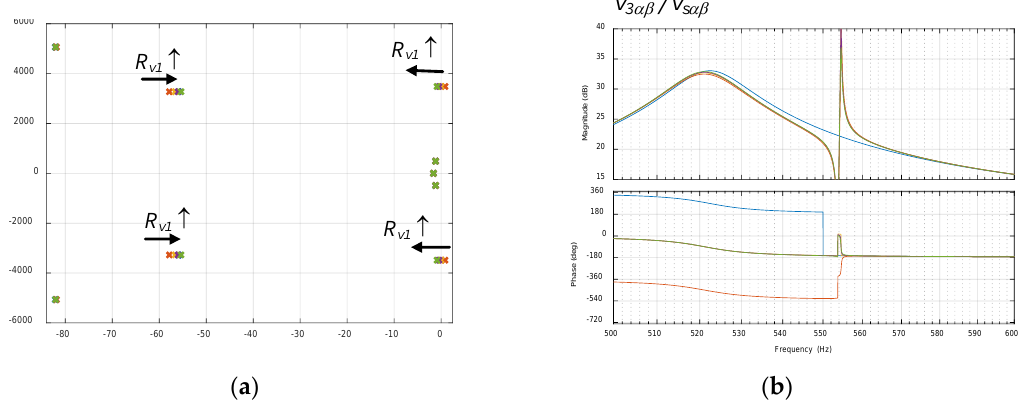
Figure 14. Dominant poles and Bode plots of the voltage at the Pcc with altered AC grid impedance ( C 1 ·1.4) and with different active resistances ( R v 1 = 1.51 k Ω multiplied by factors (1 1.5 2 3)) programmed at 550 Hz. ( a ) Dominant poles of the system, ( b ) Bode plot of v 3 αβ ( s )/ v sαβ ( s ).